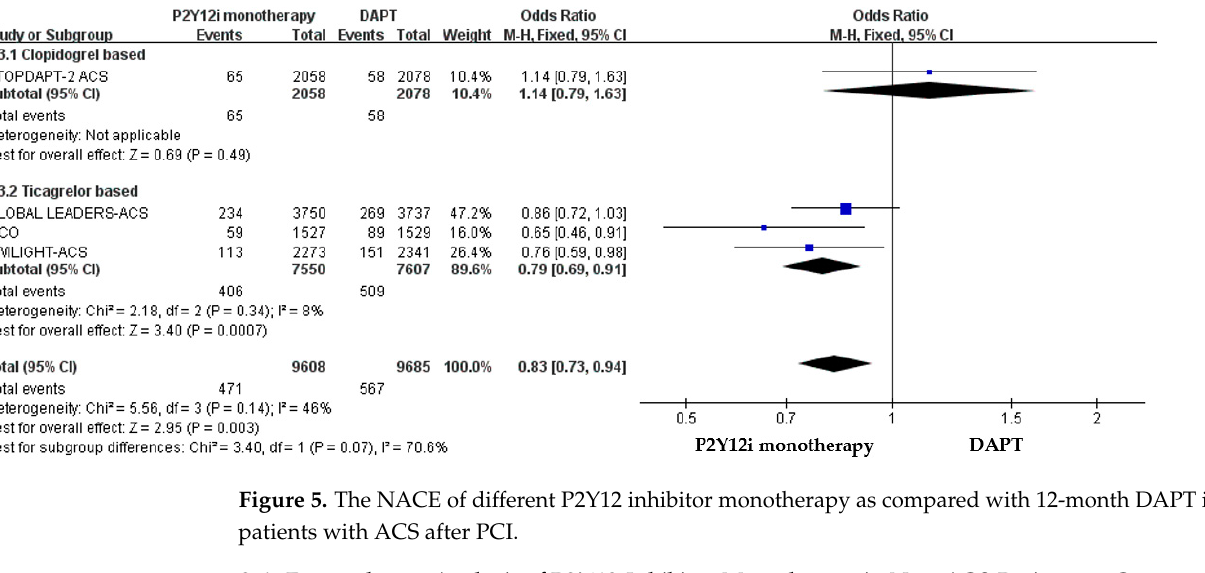
Figure 4. The safety outcomes (major or minor bleeding events) of different P2Y12 inhibitor mono- therapy as compared with 12-month DAPT in patients with ACS after PCI.